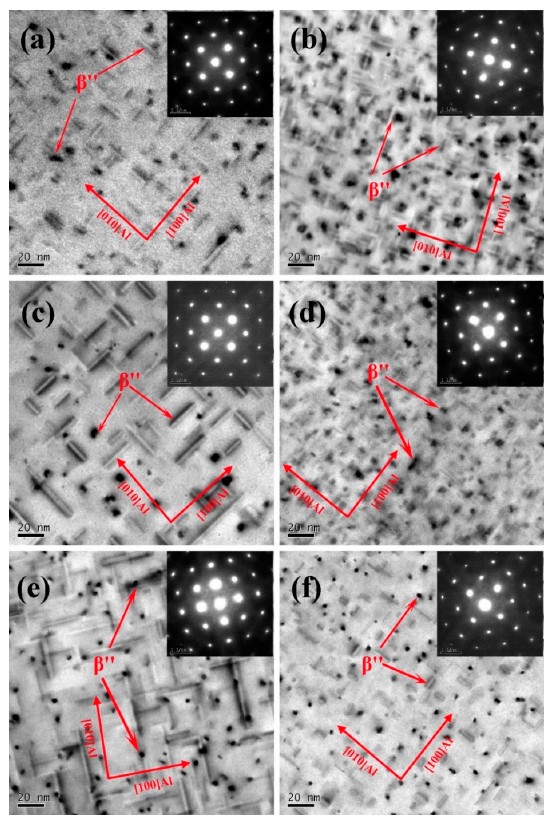
Figure 3. Transmission electron microscopy (TEM) images of the six investigated alloys artificially aged to peak hardness: ( a ) H–M; ( b ) H–M–Sn; ( c ) B–M; ( d ) B–M–Sn; ( e ) L–M; ( f ) L-M–Sn.